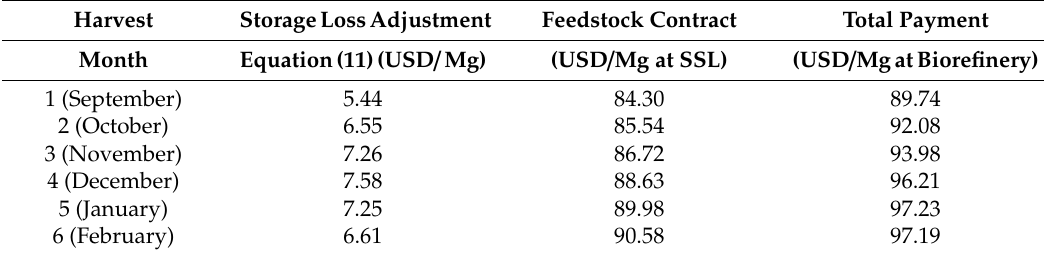
Table 12. Feedstock contract payments showing influence of the storage loss adjustment (Scenario 2). (Results obtained with Scenario 2 MATLAB